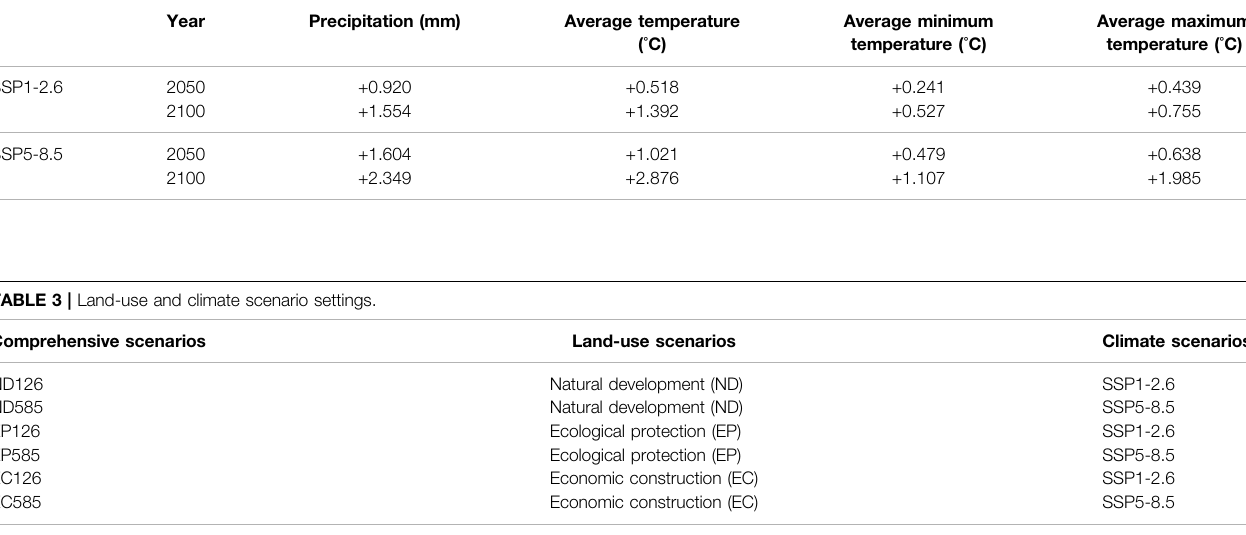
TABLE 2 | Change values of climate elements in the ZMR under SSP1-2.6 and SSP5-8.5 scenarios in 2050 and 2100.